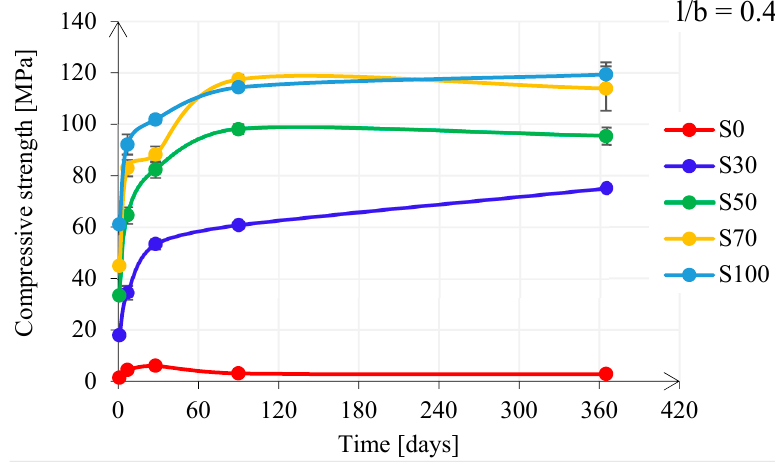
Figure 11. Compressive strength development for pastes with l/b = 0.4.